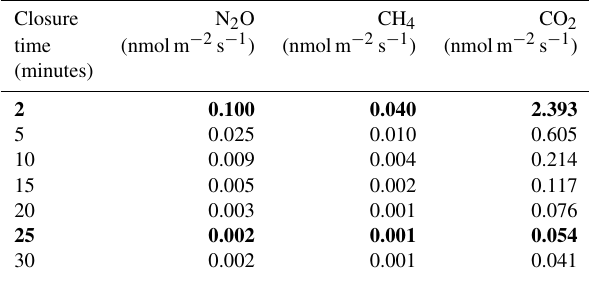
Table 1. Minimum detectable fluxes (MDFs) for each gas and for closure times from 2 to 30min. The two closure times that were used in this study (2 and 25min) are highlighted in